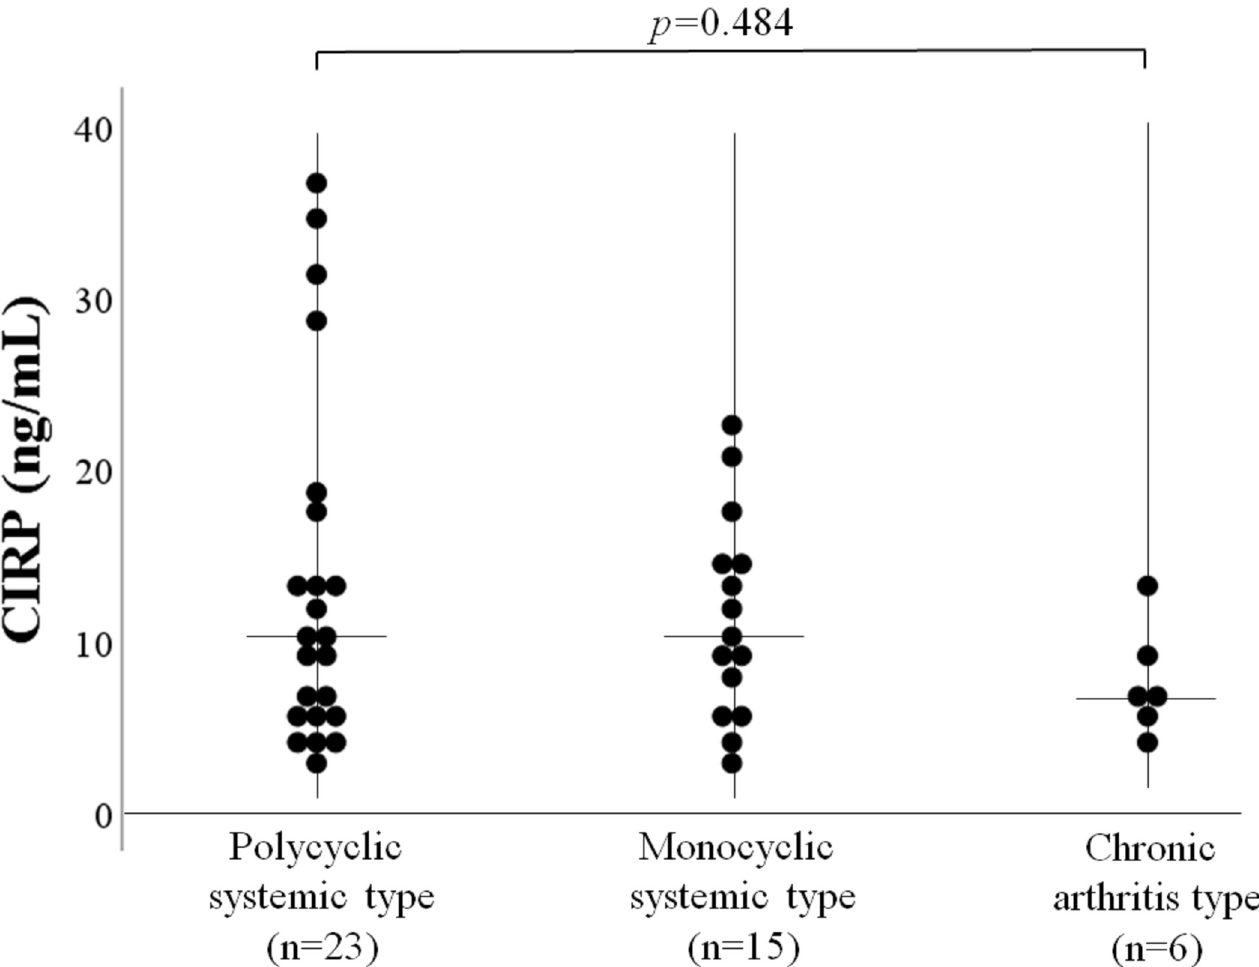
Fig 4. Serum levels of CIPR in AOSD patients with three different phenotypes. We compared serum levels of CIRP among AOSD patients with three different disease phenotypes. There was no significant difference in serum levels of CIRP among AOSD patients with three different disease phenotypes.